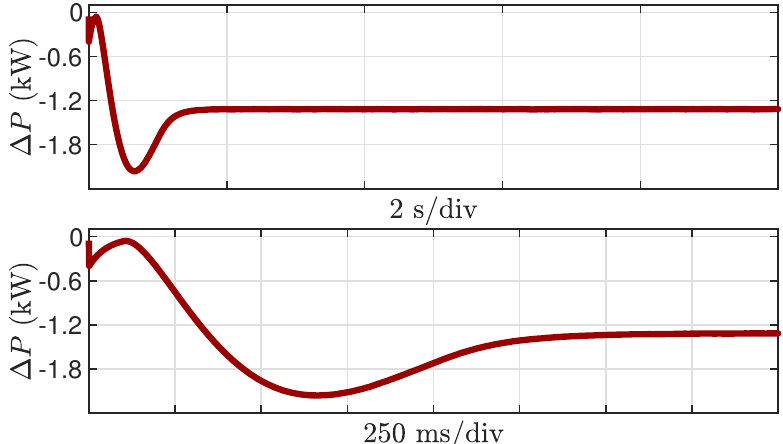
Figure 19. Test Case II: NLC ∆ P value obtained with “virtual V 2